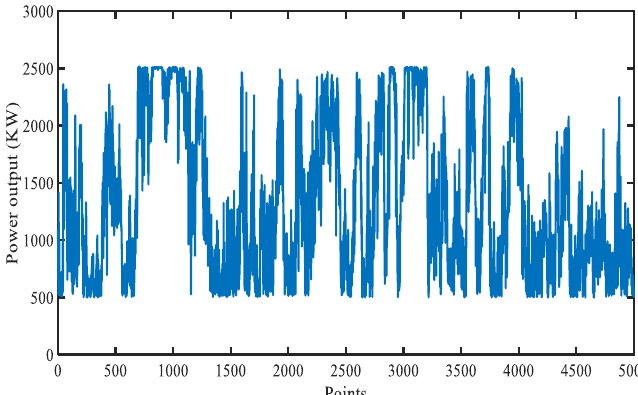
Figure 13. Actual wind speed of the wind turbine.